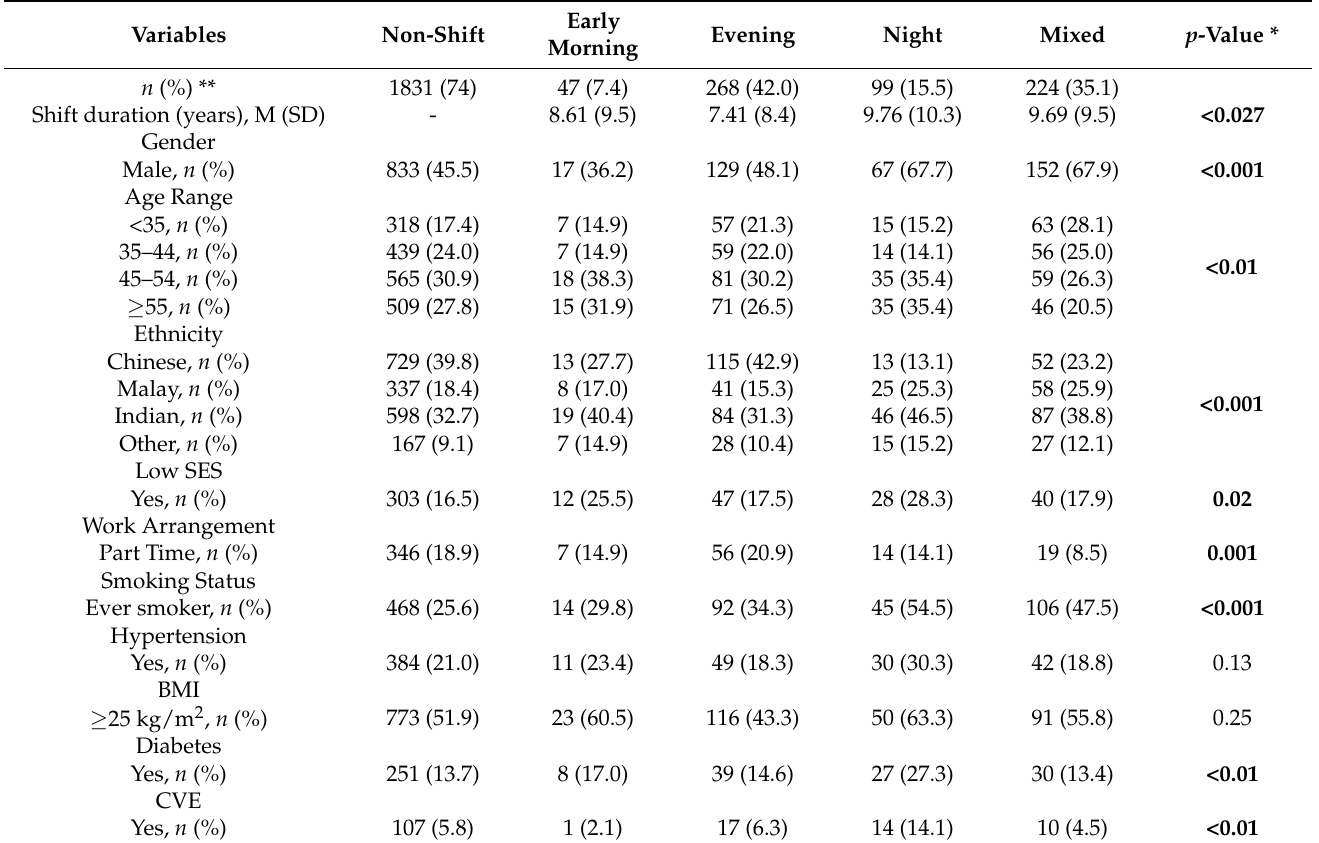
Table 1. Demographic characteristics of shift workers stratified according to their reported shift schedule